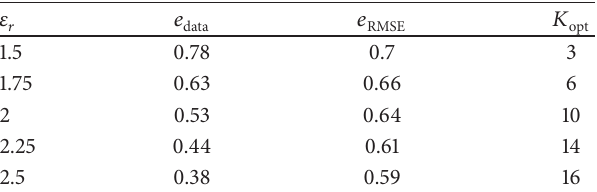
Table 4: Error measures for different values of the relative dielectric permittivity. Homogeneous dielectric cube.